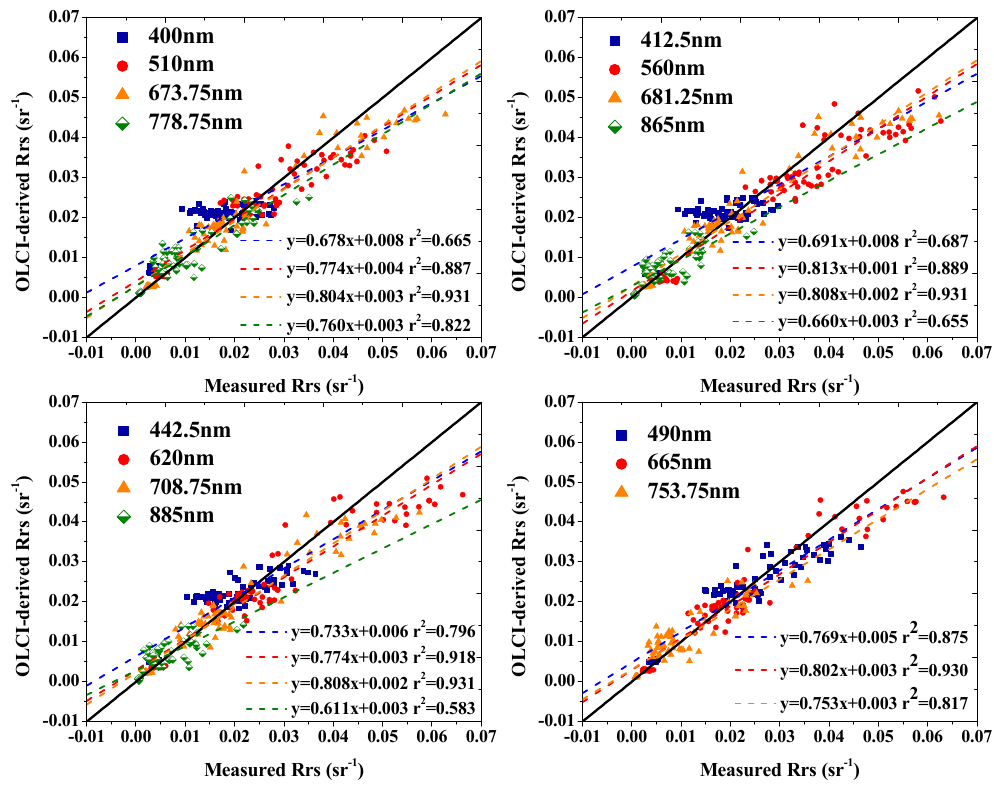
Figure 7. OLCI-derived R rs (sr − 1 ) versus measured in situ R rs (sr − 1 ) at 15 bands with central wavelengths of 400, 412.5, 442.5, 490, 510, 560, 620, 665, 673.75, 681.25, 708.75, 753.75, 778.75, 865, and 885 nm. Respective bands are denoted by symbols. The solid black lines represent the 1:1 line. The dashed lines represent the regression lines.